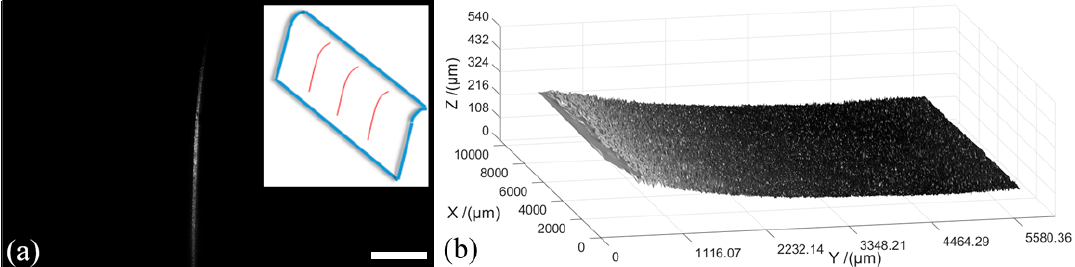
Figure 9. Surface topography measurement and curvature calculation of an opaque mobile phone protective shell. ( a ) The curved side of the shell irradiated by the light-sheet. Scale bar: 1 mm. ( b ) Calculated 3D surface topography of the phone shell.